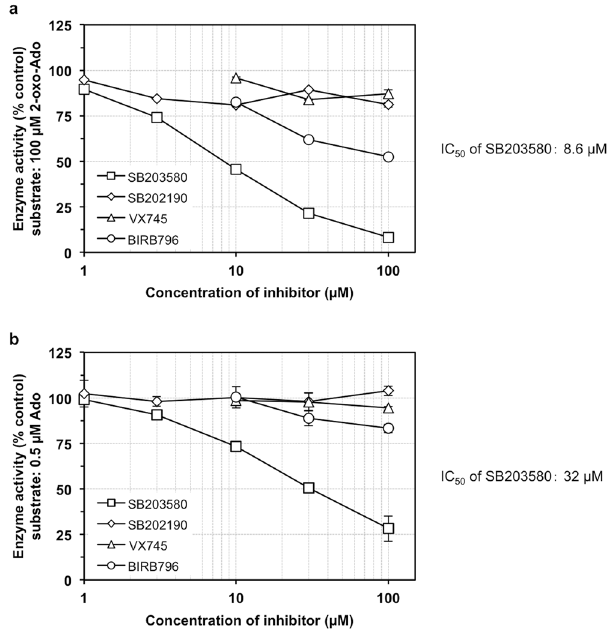
Figure 7. SB203580 directly inhibits adenosine kinase. ( a , b ) Recombinant human ADK, ATP and nucleosides 2-oxo-Ado ( a ) or Ado ( b ) were reacted in the presence of various concentrations of inhibitors. Enzyme activity was determined by the amount of monophosphate products, 2-oxo-AMP ( a ) or AMP ( b ). Product quantities were determined by HPLC. Values (% control) of enzyme activity relative to that in the absence of inhibitors are shown as the mean ± SD of three experiments. IC 50 was calculated